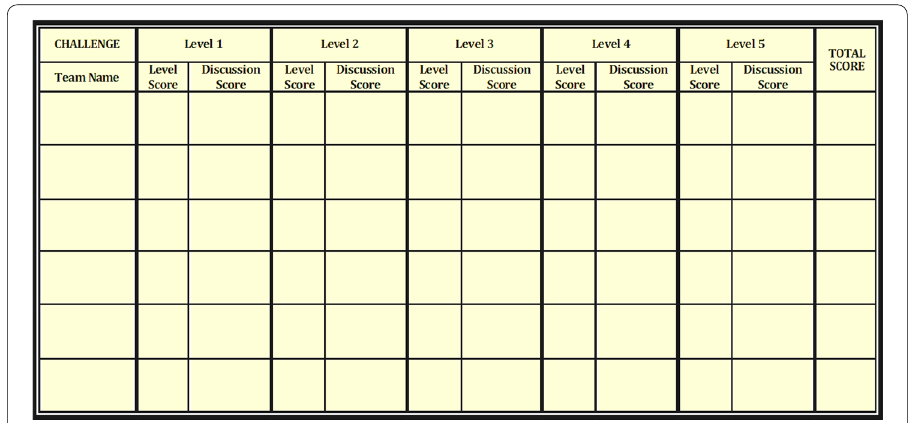
Fig. 9 Leader Board Designed for the Gamification